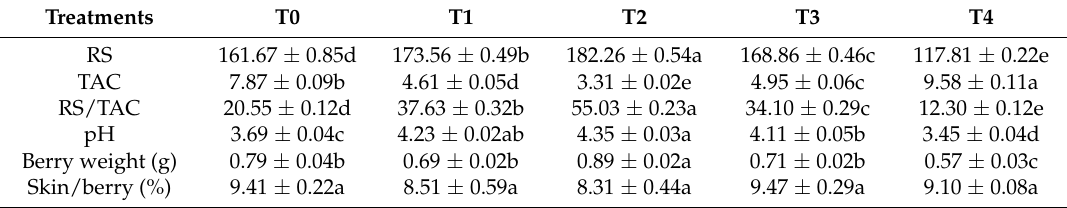
Table 1. Physical and chemical analyses of Cabernet Sauvignon berries and grape juice sampled from each iron supply treatment. RS = Reducing Sugar (expressed in gram equivalent glucose L − 1 ), letters indicate significant differences between treatments as calculated by Tukey’s HSD test ( p <